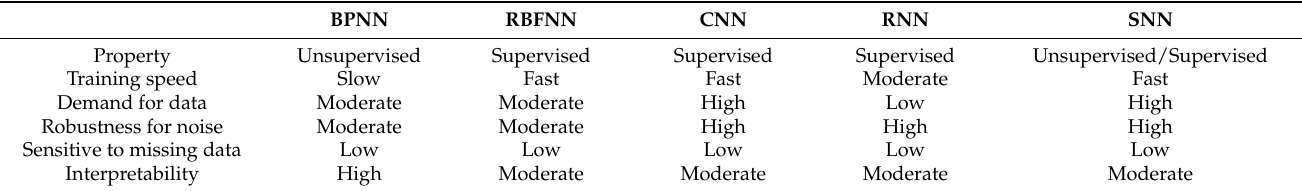
Table 2. Comparison based on neural network gas identification